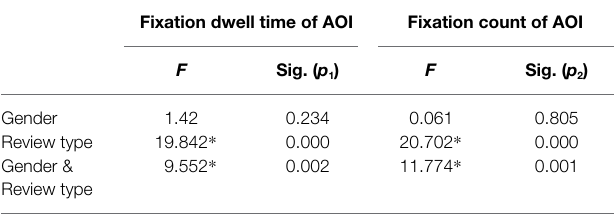
TABLE 2 | Results of ANOVA